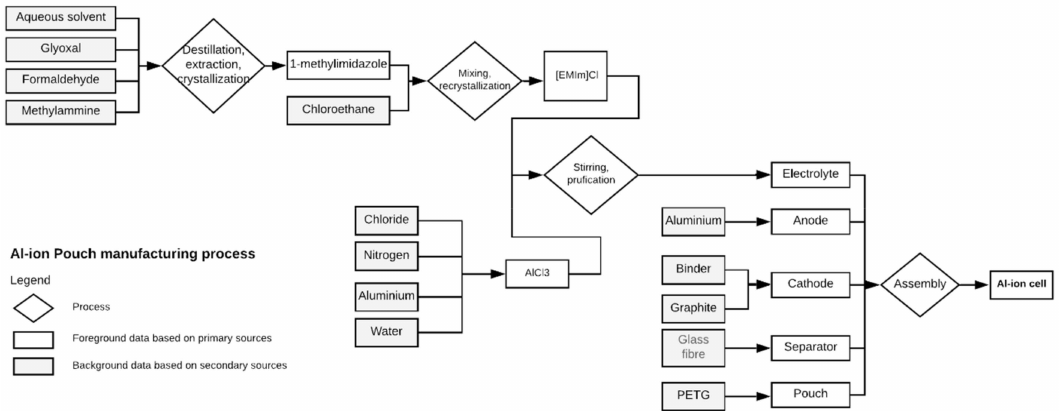
Figure 1. Production process of an Al-ion 18650 battery. The rhombuses represent the unit operations. The grey boxes illustrate the background datasets which are based on secondary data and the white boxes show the foreground datasets which are compiled from primary